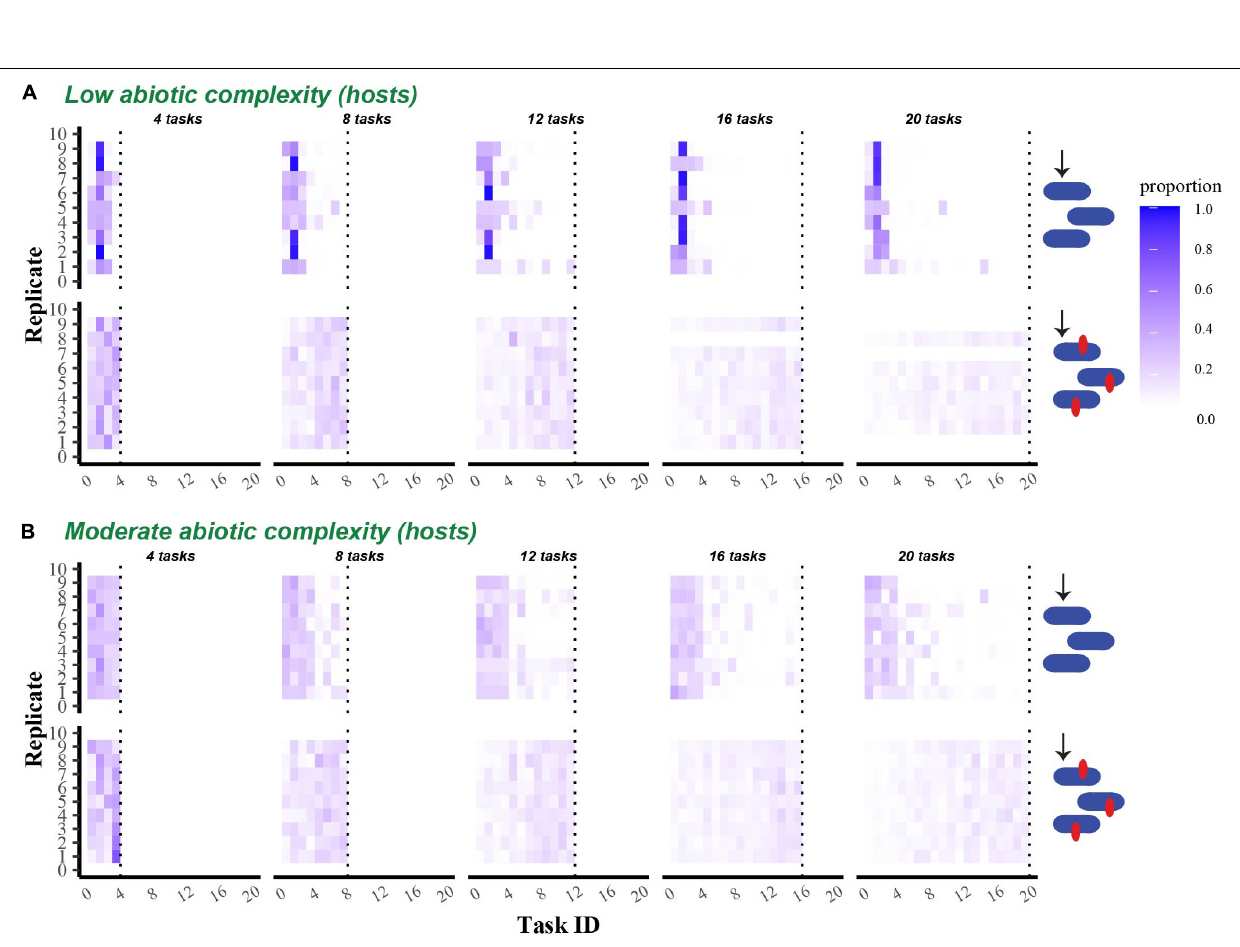
FIGURE 5 | Proportion of the final evolved host population that performed each possible task. Heat maps show the proportion of the final host population at the end of 300,000 updates that successfully performed each task. (A) Shows data from populations that evolved in a single resource environment, while (B) shows data from populations that evolved in a four-resource environment. In both (A,B) , the first row shows data from non-coevolving populations, while the second shows data from coevolving populations. Tasks are indicated on the x-axis in rank order (see section “Materials and Methods), and the data from replicate communities are stacked